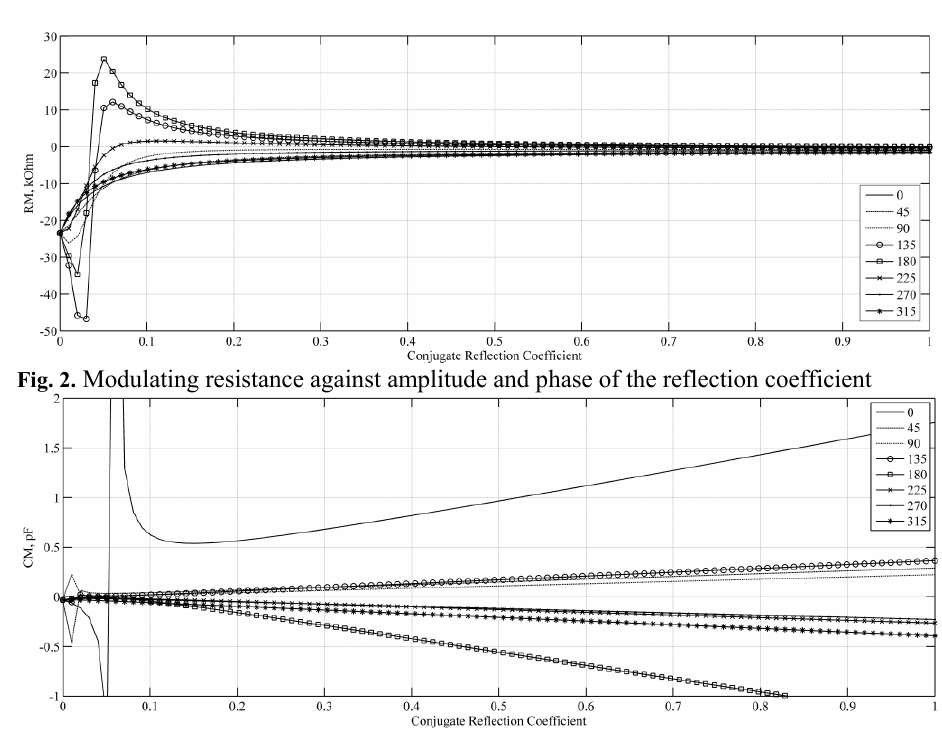
Fig. 2. Modulating resistance against amplitude and phase of the reflection coefficient